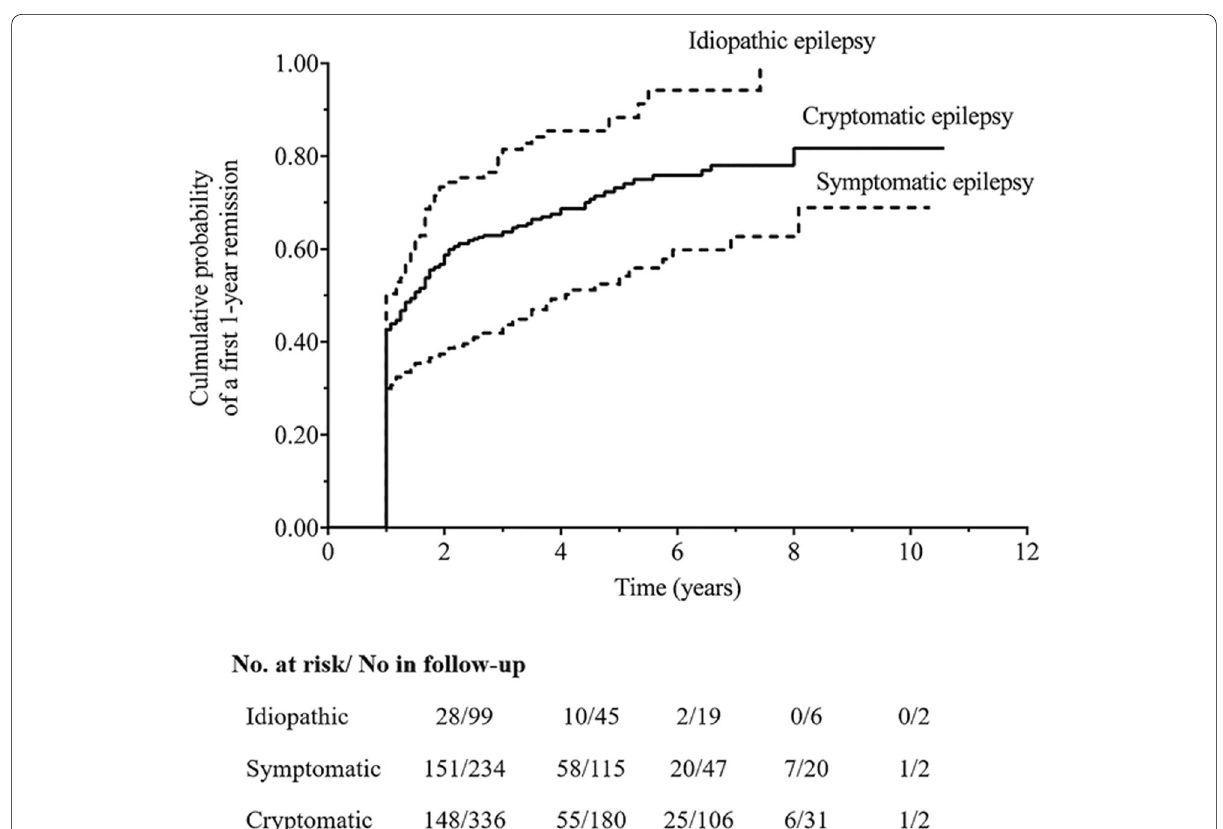
Fig. 2 Kaplan-Meier analyses of a significant predictive factors for the first 1-year remission: the type of